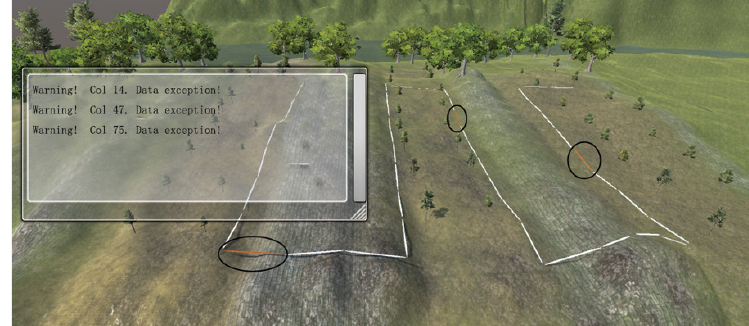
Figure 8. Vibration source alarm before using the isolation method.